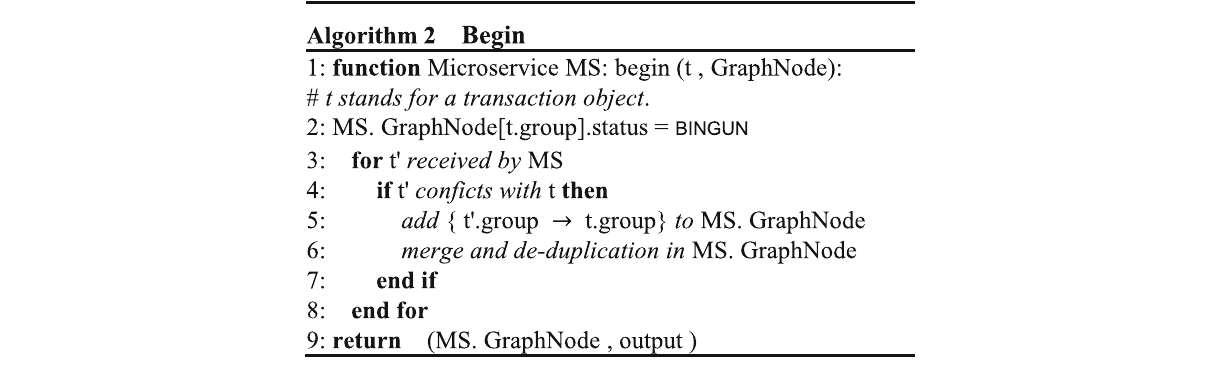
Table 3 Algorithm implementation of Begin